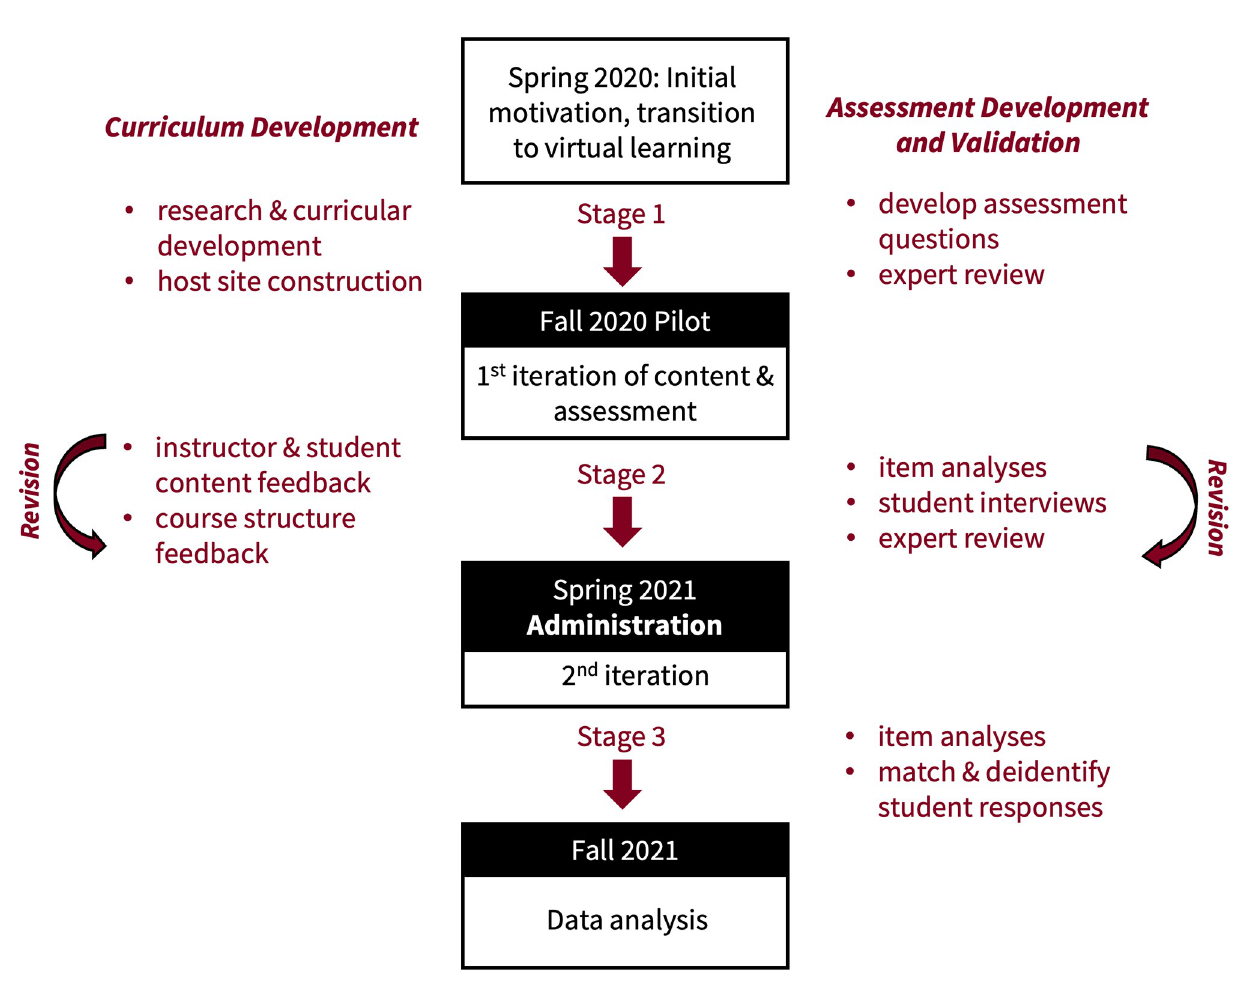
Fig 1. PARE-Seq curriculum and assessment tool development and revision process. Both curriculum and assessment instrument were revised between the Fall 2020 pilot and Spring 2021